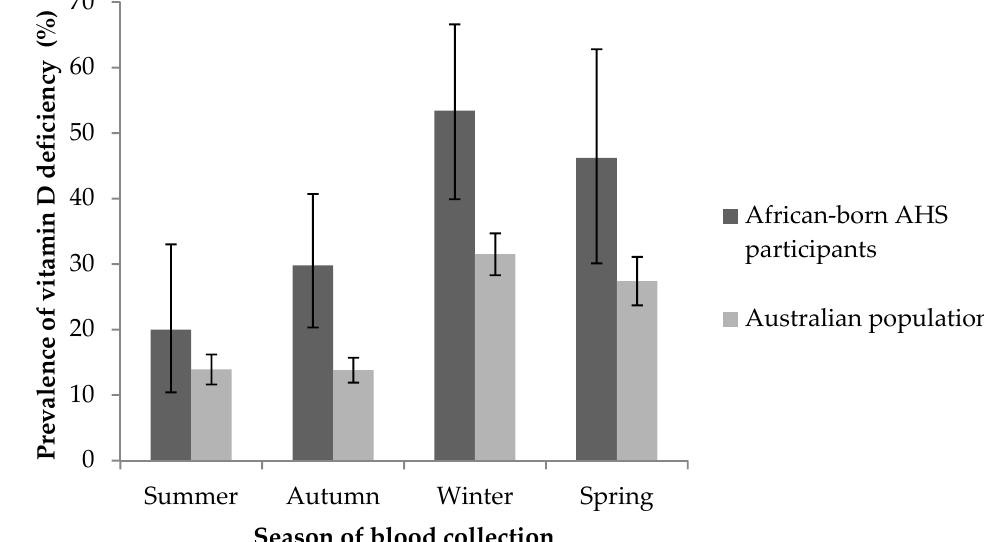
Figure 2. Prevalence (error bars 95% confidence interval) of vitamin D deficiency (serum 25-hydroxyvitamin D concentration < 50 nmol / L) in African-born adults aged ≥ 18 years who participated in the Australian Health Survey (AHS) ( n = 236) compared to the general Australian population.